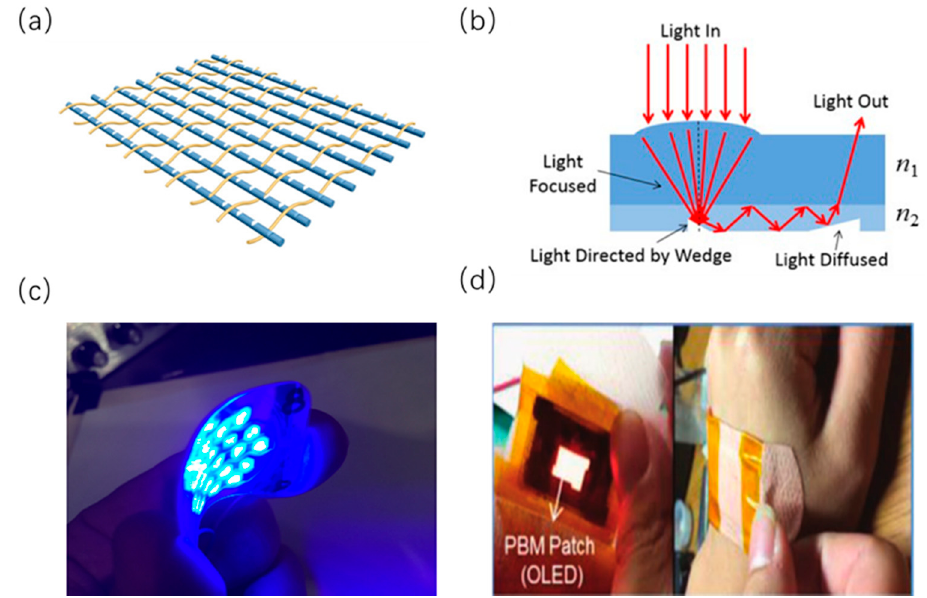
Figure 8. Integrated wearable optical devices for therapy. ( a ) Woven fabrics produced from cotton yarns and polymer optical fibers (POF). Reprinted with permission from [82]. Copyright 2013, OSA. ( b ) An illustration of the light rays propagating through the optical device. Reprinted with permission from [83]. Copyright 2016, SPIE. ( c ) Blue 450 nm printed LED substrate. Reprinted with permission from [89]. Copyright 2019, SPIE. ( d ) Photograph of the patch attached to a human skin. Reprinted with permission from [87]. Copyright 2018, WILEY-VCH.